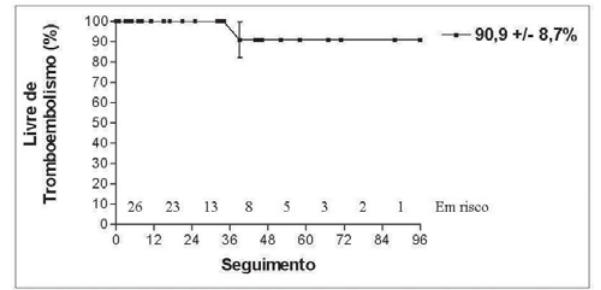
Fig. 3 - Curva livre de tromboembolismo em 8